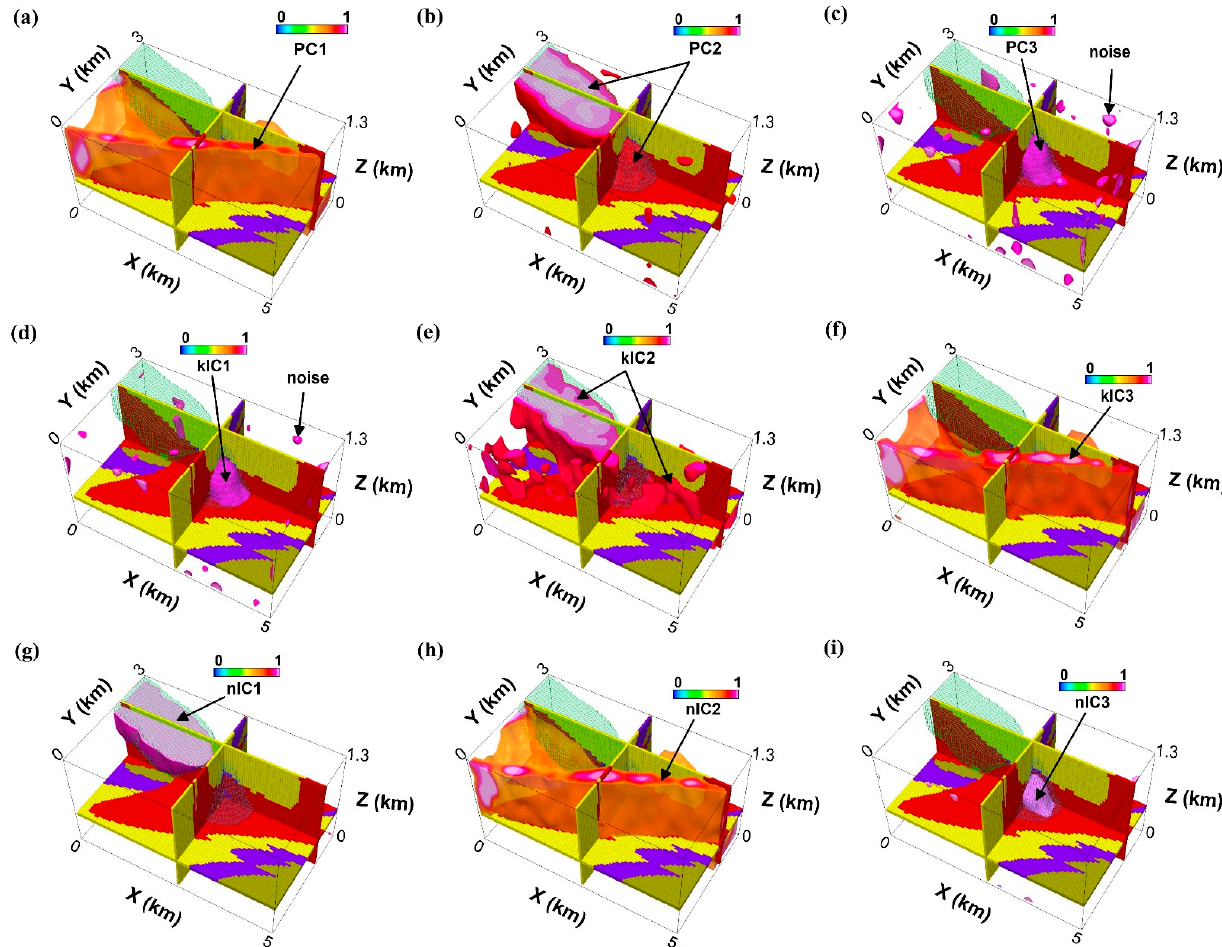
Figure 7. Assessment of different source separation methods: ( a – c ) principal components (PC1, PC2, and PC3) from the PCA method; ( d – f ) independent components (kIC1, kIC2, and kIC3) from Fast-ICA by kurtosis maximization; ( g – i ) independent components (nIC1, nIC2 and nIC3) from Fast-ICA by negentropy maximization. PCA recreates another set of overlapped images on PC2 and is ineffective in source separation ( a – c ). Fast-ICA by kurtosis maximization produces a set of images (kICs) separated to some extent, but still, some of the features remain mixed in the first and second independent components in the form of outliers, background geology mixed with the second alteration event. Fast-ICA by negentropy maximization produces a set of images (nICs) that are efficiently separated ( g – i ). All principal and independent components were normalized from zero to one for consistency of visualization.